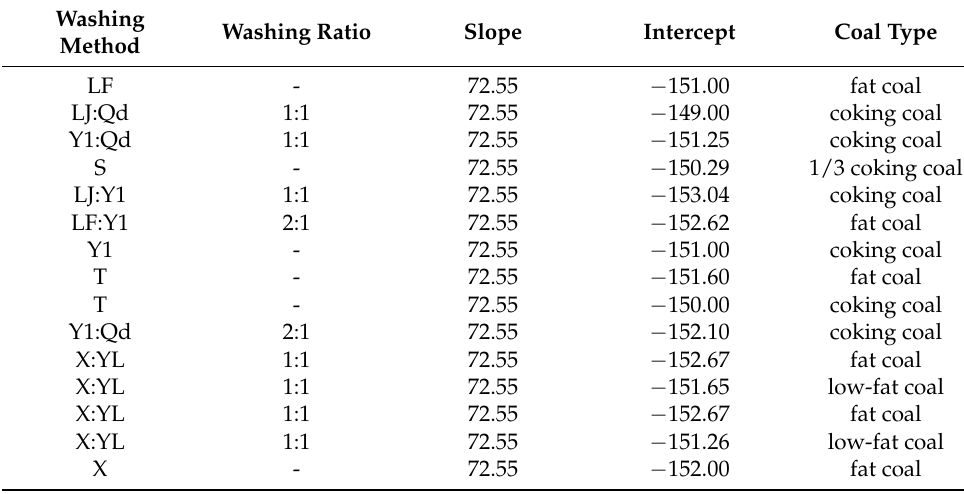
Table 11. Parameters for the online ash monitor in production system #3.